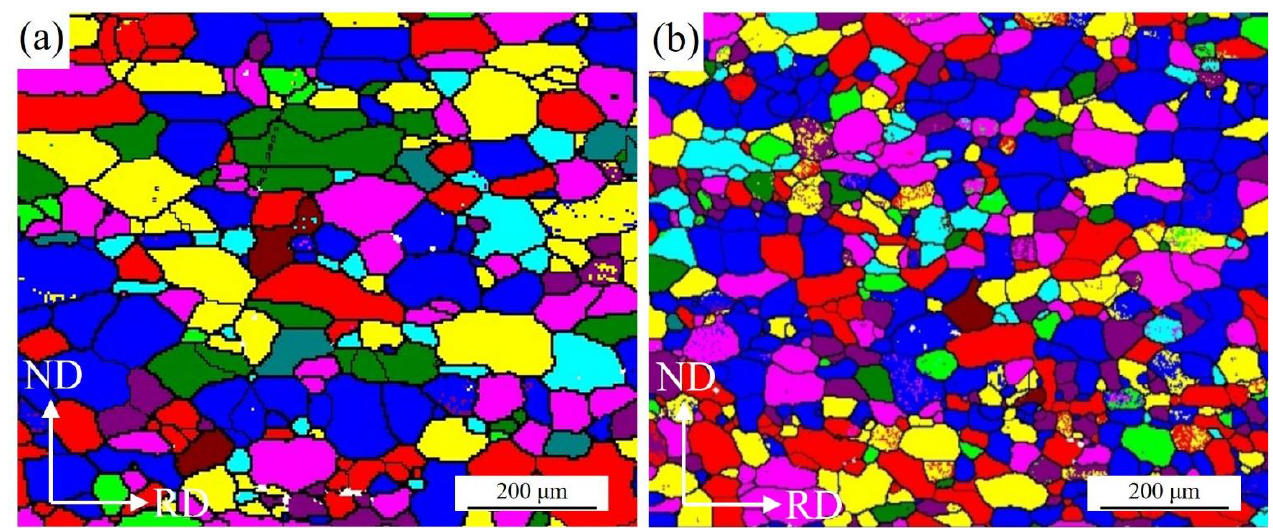
Figure 5. The EBSD map of the Al-0.5%Cu alloy sheets annealed at 300 °C for 80 min in two different heating rates: ( a ) SH; ( b ) RH.